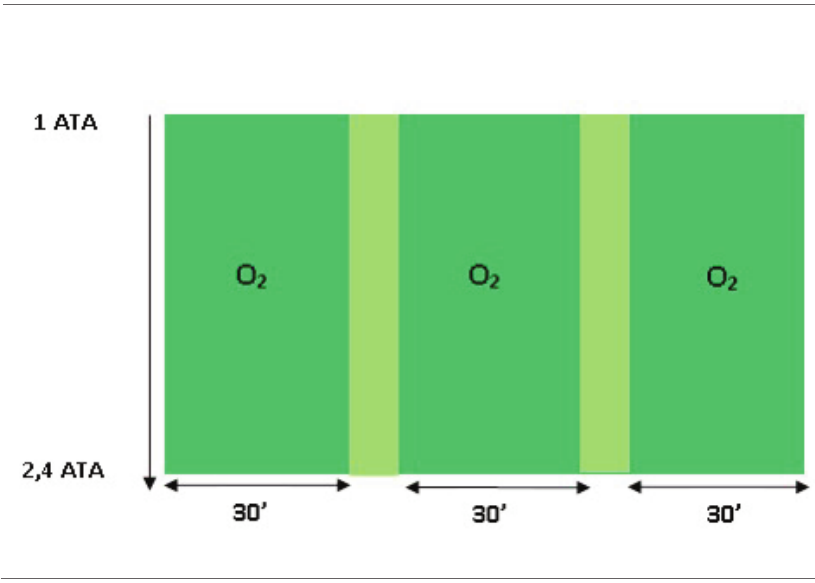
Figure 2. HBO exposure duration in one